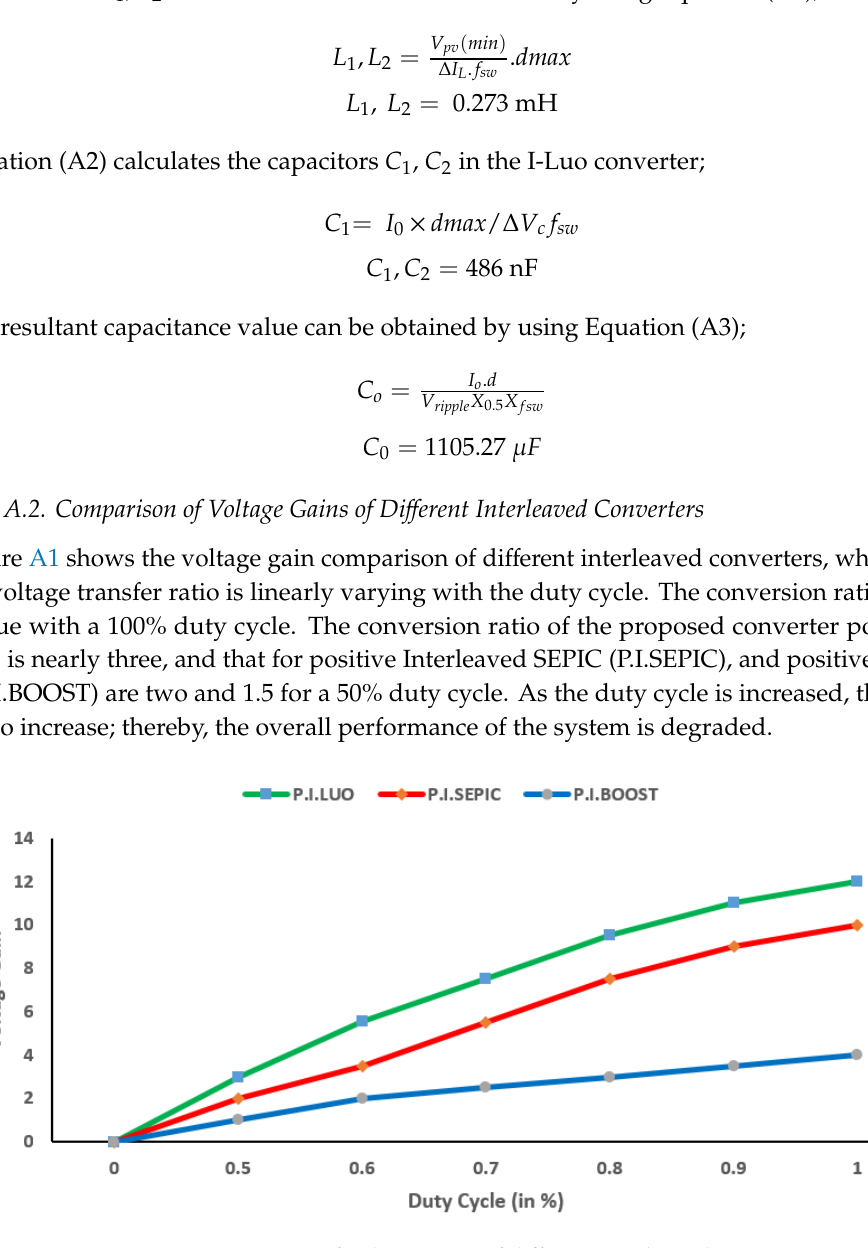
Figure A2. Efficiency comparison of different converters with the optimized controller.